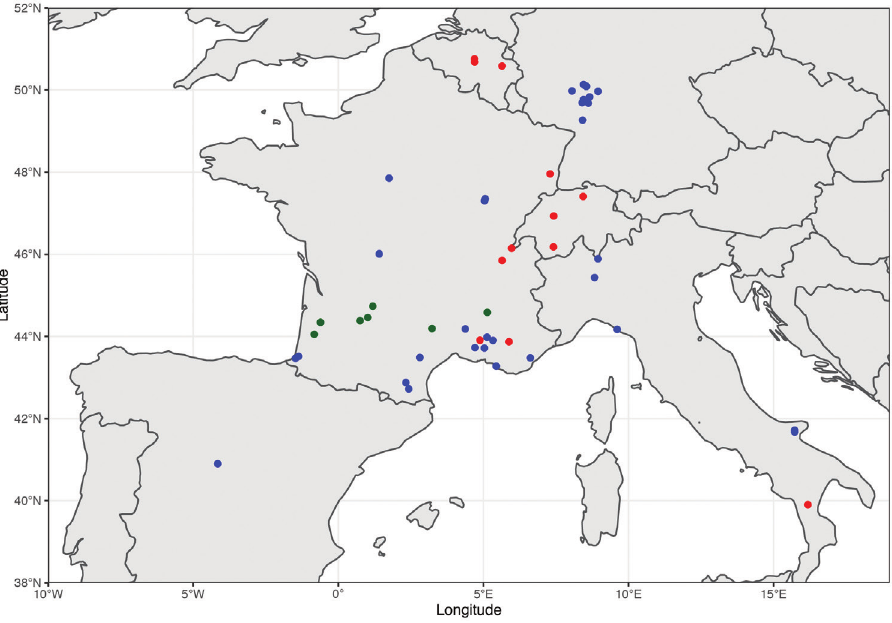
Figure 55. Distribution map of Andrena gelriae (red dots), A. ovata (blue dots) and A. vocifera (green dots). weak tergal punctation are also known from Eastern Europe. Future research is needed to determine whether these slight genetic and morphological differences point to the presence of additional cryptic diversity in A. wilkella